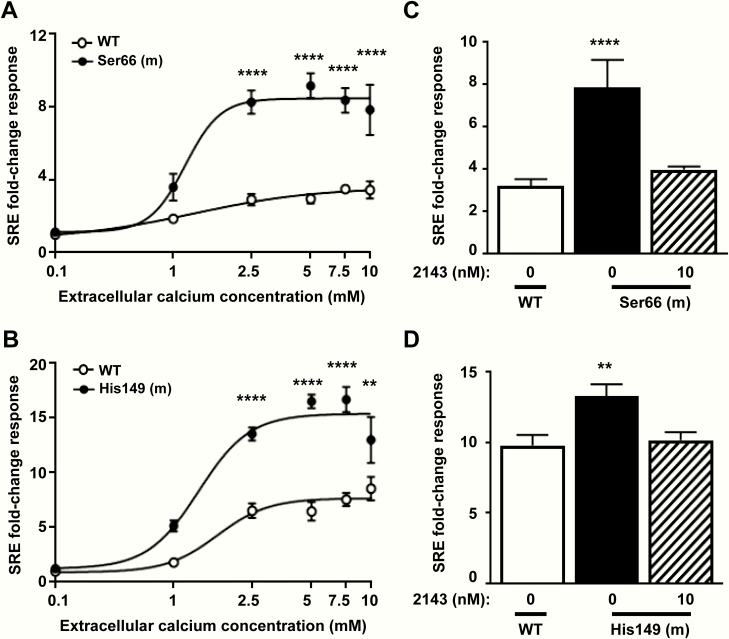
SRE luciferase reporter responses of the Ser66 and His149 Gα 11 mutants and effects of NPS 2143 (2143) treatment. [Ca2+]e-induced SRE luciferase reporter responses of HEK-CaSR cells transfected with WT (open symbols) or mutant (m) (filled symbols) (A) Ser66 or (B) His149 Gα 11 proteins. Responses at each [Ca2+]e are expressed as a fold-change of low (0.1 mM) [Ca2+]e responses, and shown as mean ± SEM of 8 independent transfections. The Ser66 and His149 Gα 11 mutants led to significantly increased SRE fold-change responses following stimulation with Ca2+e compared with WT Gα 11. Statistical analysis comparing mutant to WT responses by 2-way ANOVA with Tukey’s multiple-comparisons test. (C-D) [Ca2+]e-induced SRE reporter responses to 7.5 mM Ca2+e in HEK-CaSR cells transfected with WT (open bar) or mutant (filled bars) (C) Ser66 or (D) His149 Gα 11 proteins. The addition of 10nM NPS 2143 rectified the elevated SRE reporter responses of the mutant (hatched bars) to WT (open bars) levels. Responses are expressed as a fold-change of low (0.1 mM) [Ca2+]e responses, and shown as mean ± SEM of 4–8 independent transfections. Statistical analyses were performed by 1-way ANOVA with Dunnett’s multiple comparisons test compared to the WT response. ****P < 0.0001, **P < 0.01 for all panels.